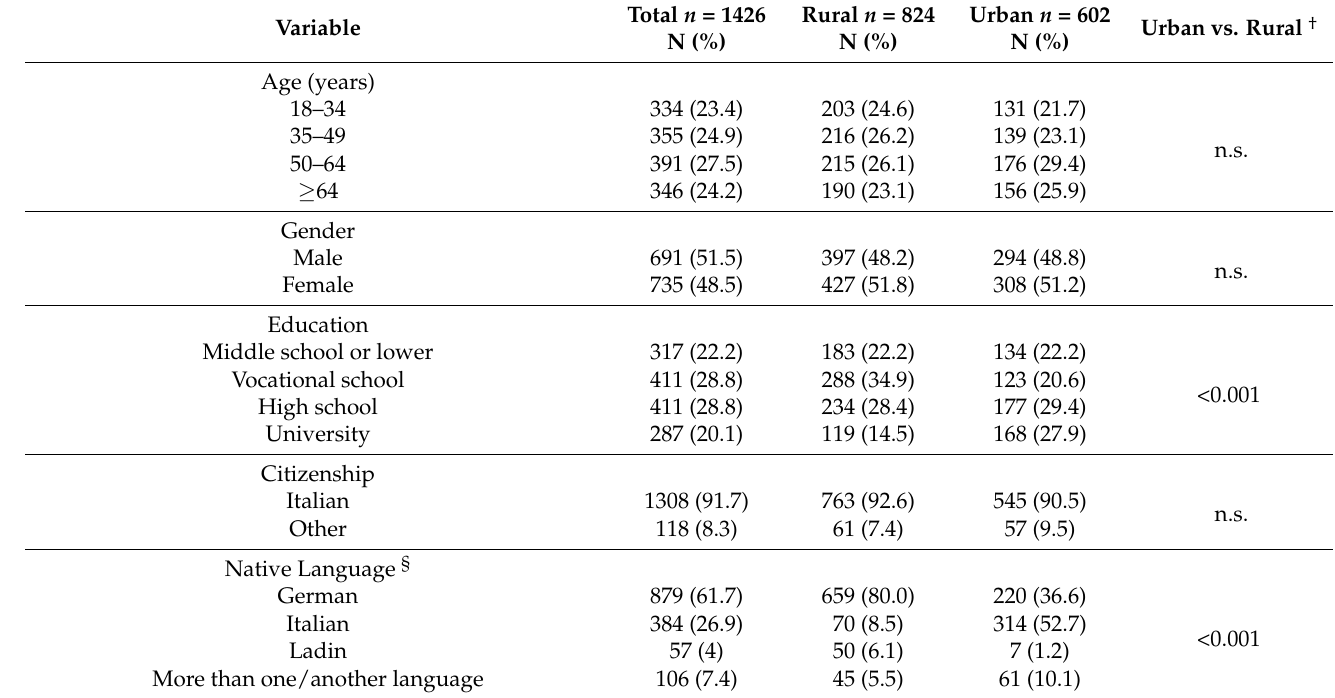
Table 1. Characteristics of the sample and comparison between urban and rural